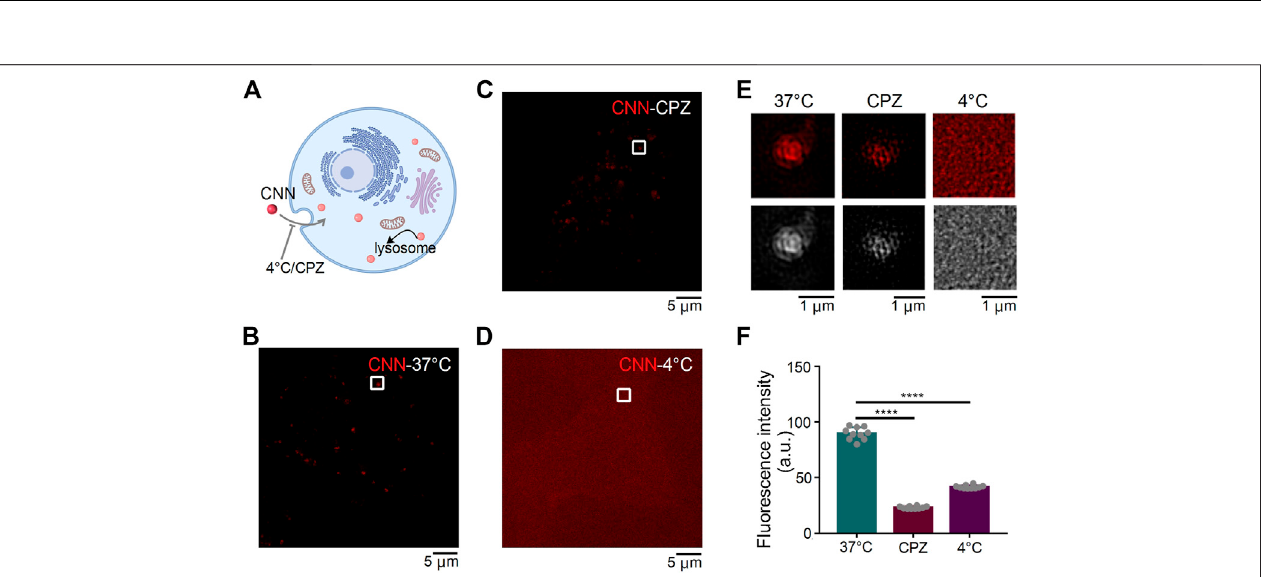
FIGURE 3 | SIM images of CNN under different conditions in H9C2 cells. (A) Effect of different treatment conditions on CNN entry into cells. (B) H9C2 cells were incubated with CNN (0.5 μ M, λ ex = 405 nm) for 1 h at 37 ° C. (C) H9C2 cells were incubated with the Chlorpromazine (CPZ, 20 μ M) at 37 ° C for 2 h and incubated with CNN at37 ° Cfor1 h (D) H9C2cellswereincubated withCNN for1 hat 4 ° C. (E) Fluorescenceandgrayscaleimagesoftheenlargedregionindicatedbywhiterectangles in (B,C,D) . (F) Fluorescence intensity of CNN with 37 ° C, 4 ° C and CPZ. Data are presented as mean ± SEM ( n = 10, **** p < 0.0001). All compared with 37 ° C.